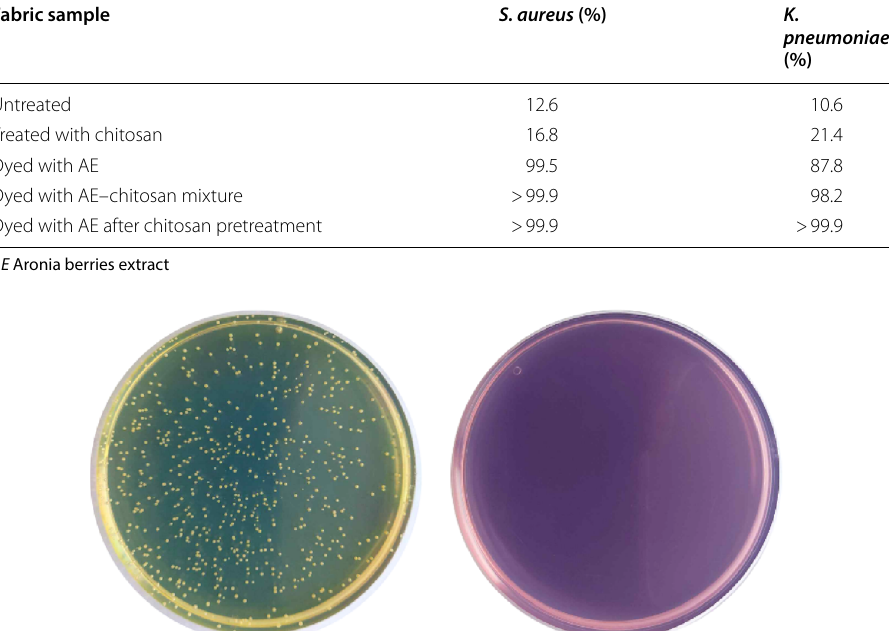
Table 3 Antibacterial activity of cotton fabrics Fabric sample